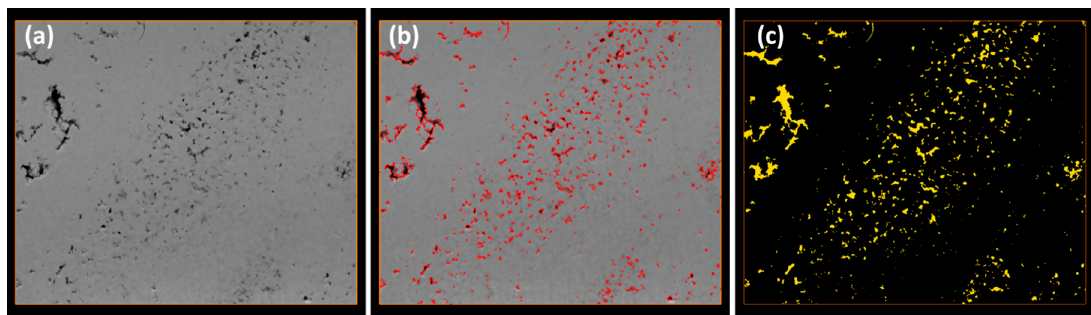
Figure 8. ( a ) Single slice image extracted from the corrected stack generated from the olivine sample; ( b ) pores are delimited at red outline; ( c ) result from segmentation of the single slice. The surface area of this slice is about 437 µm 2 .